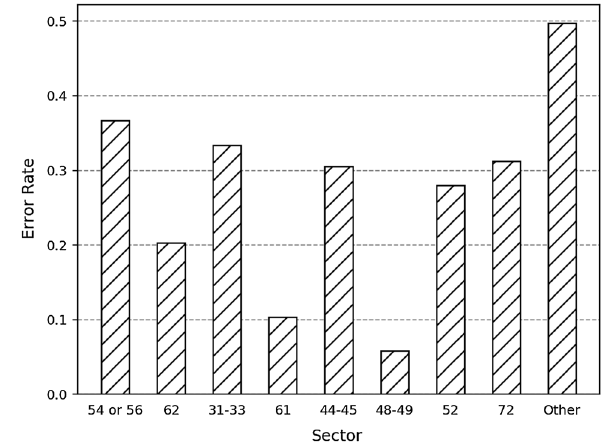
Fig. 3 Utility recall for identifying errors per industry